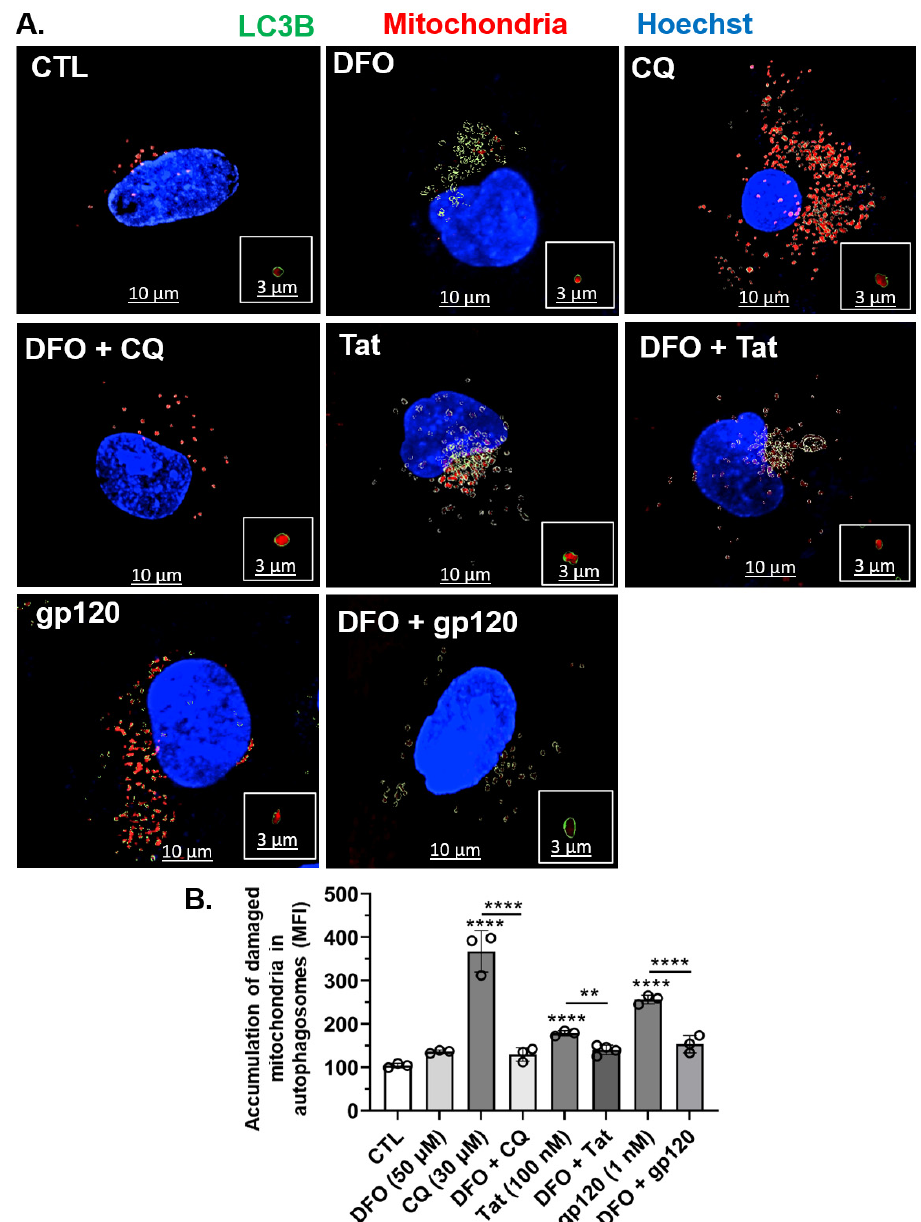
Figure 4. DFO blocked HIV-1 Tat-, gp120-, and CQ-induced accumulation of damaged mitochondria inside autophagosomes. ( A ) Imaris 3D reconstructed fluorescence microscopy images showing autophagosomes (green spherical structures), damaged mitochondria (red) inside autophagosomes (red inside green circle), and nuclei (blue). Qualitatively, DFO blocked CQ- (30 µ M), Tat- (100 nM), and gp120- (1 nM) induced increases of mitochondria inside autophagosomes. ( B ) Quantitatively, DFO blocked CQ- (30 µ M), Tat- (100 nM), and gp120- (1 nM) induced increases of mean fluorescence intensity (MFI) of mitochondria inside autophagosomes. Image analysis and quantification were performed from five independent experiments with 30 cells quantified for each experimental con- dition ( n = 150). Error bars represent standard deviation (SD) of five independent experiments. A one-way ANOVA multiple comparisons test was used to compare control and treatment groups. Cells were chosen randomly during image acquisition and analysis from the microscope field of view, and no cells were intentionally excluded. Scale bars are 10 µ m for the image and 3 µ m for the inset. ** p < 0.01 and **** p <